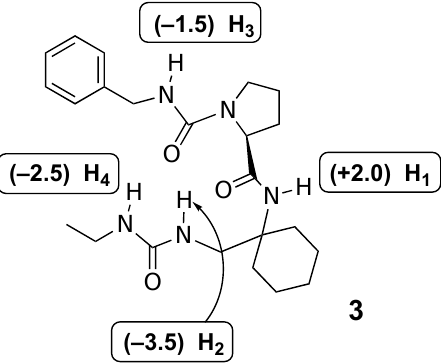
Figure 7. Values of the temperature coefficients of the proton H N protons of compound 3.